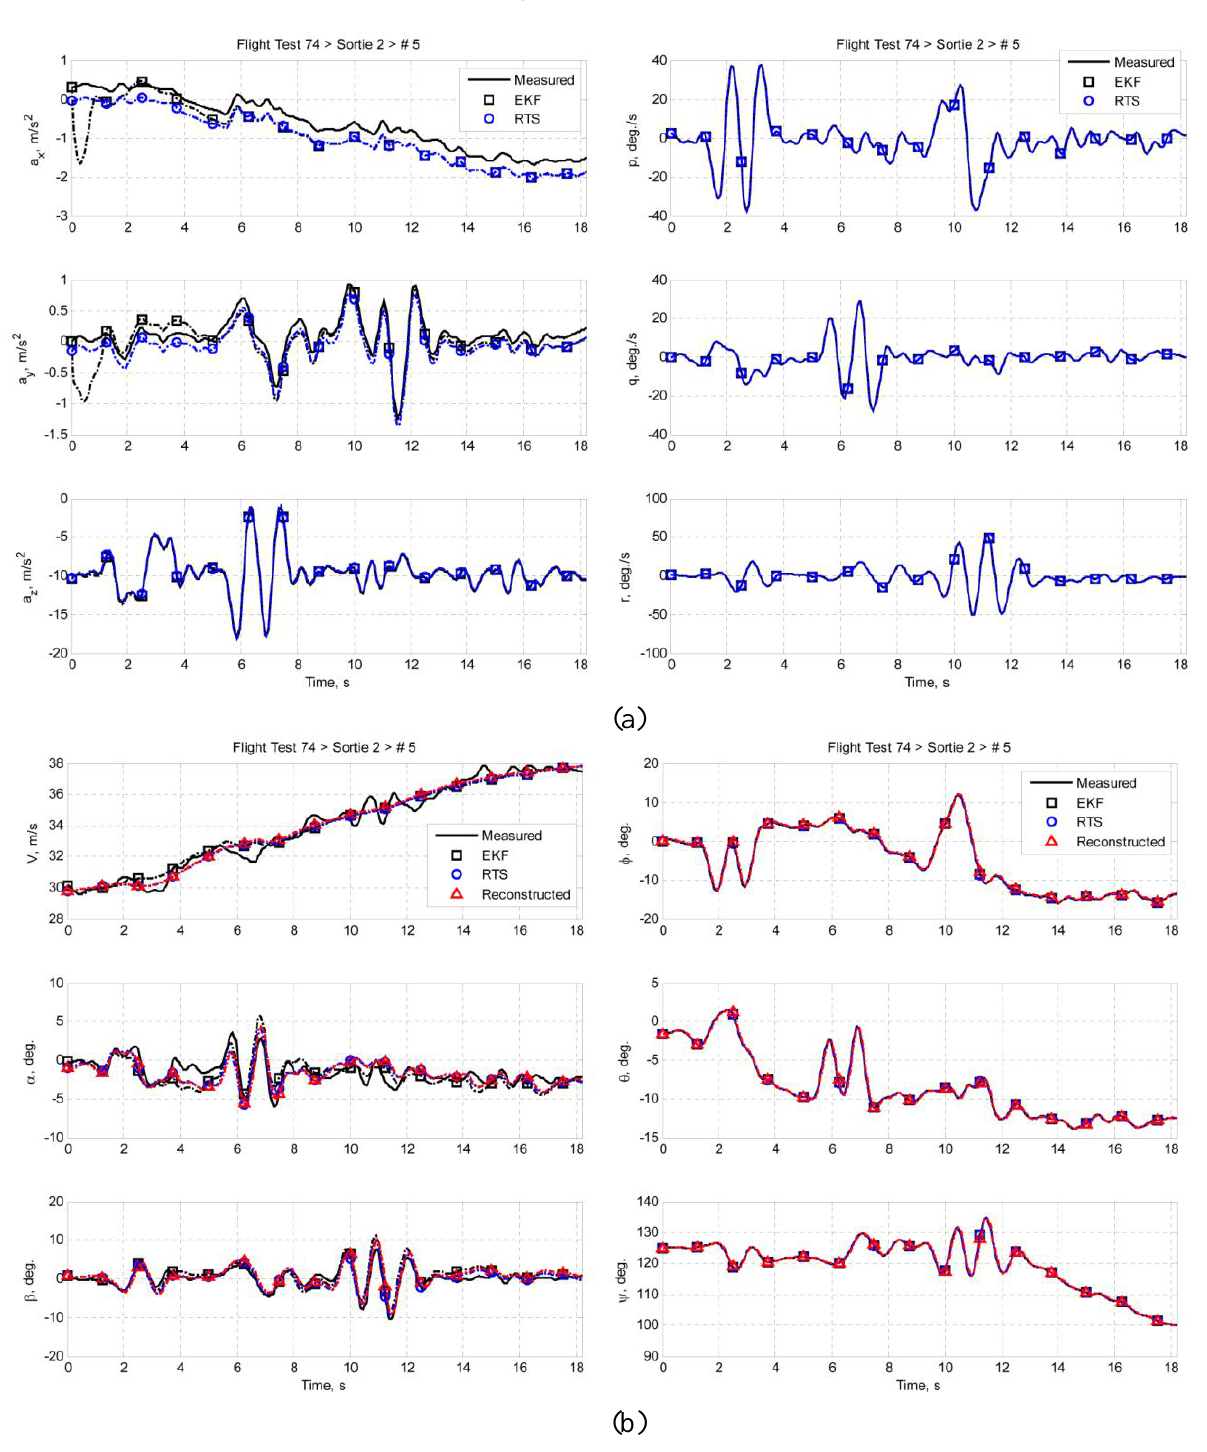
Figure 12. (a) Accelerations and angular rates of ft74srt02run05 before and after correction. (b) Airdata and attitude angles of ft74srt02run05 before and after